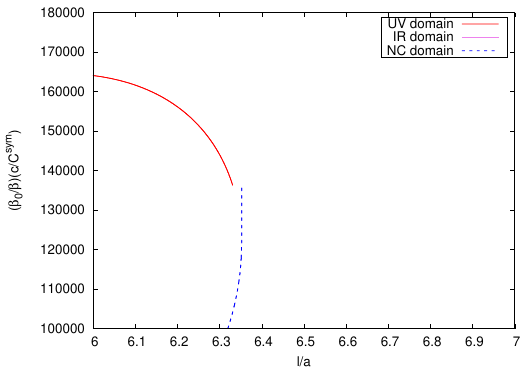
Figure 4 . Discontinuty in the c -function at the UV and the NC